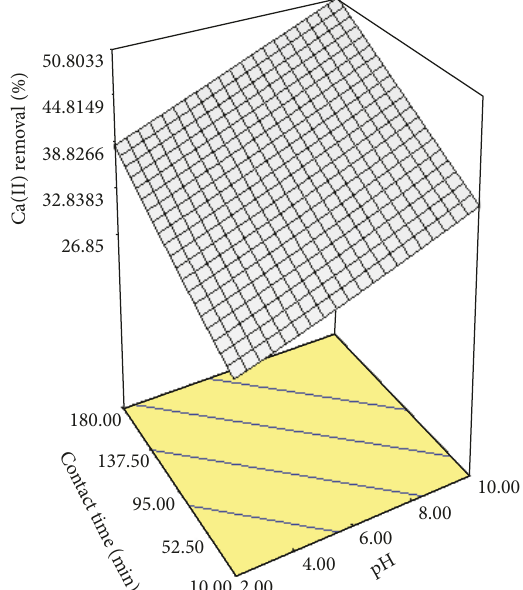
Figure 5: 3D surface plot for total hardness removal.